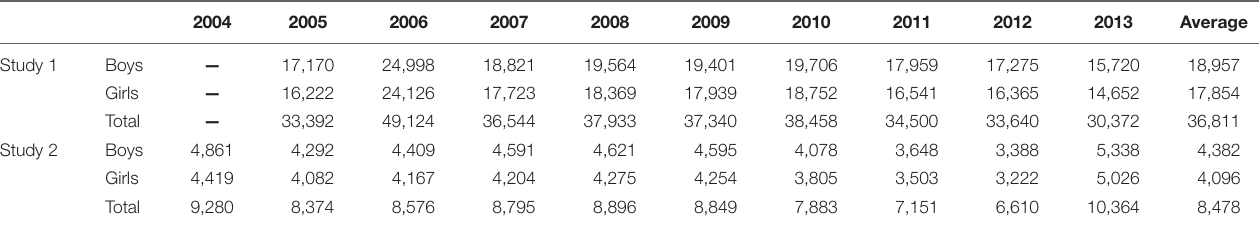
TABLE 1 | Sample sizes in Study 1 and 2.